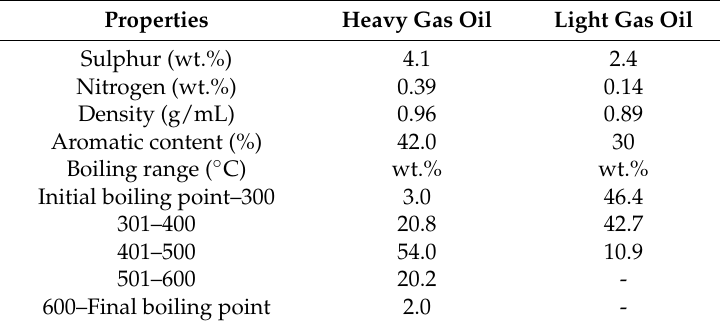
Table 6. Physical properties of heavy gas oil and light gas